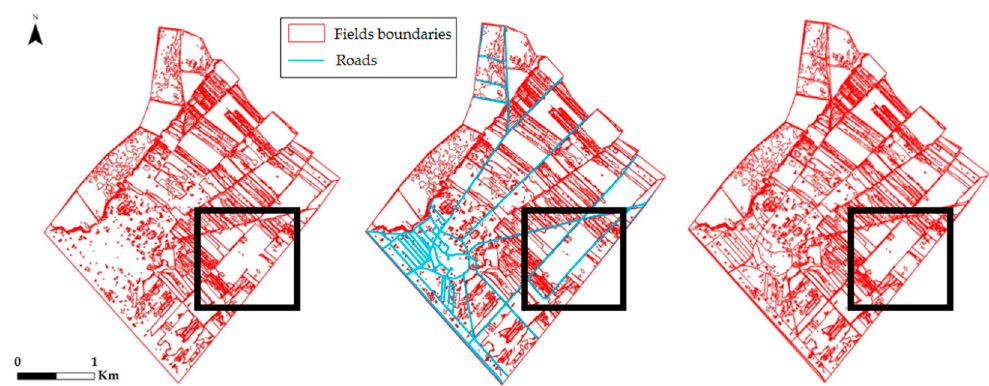
Agriculture 2019 , 9 , x FOR PEER REVIEW Figure 4. Use of road map to stake out unseparated fields. Figure 4. Use of road map to stake out unseparated fields.